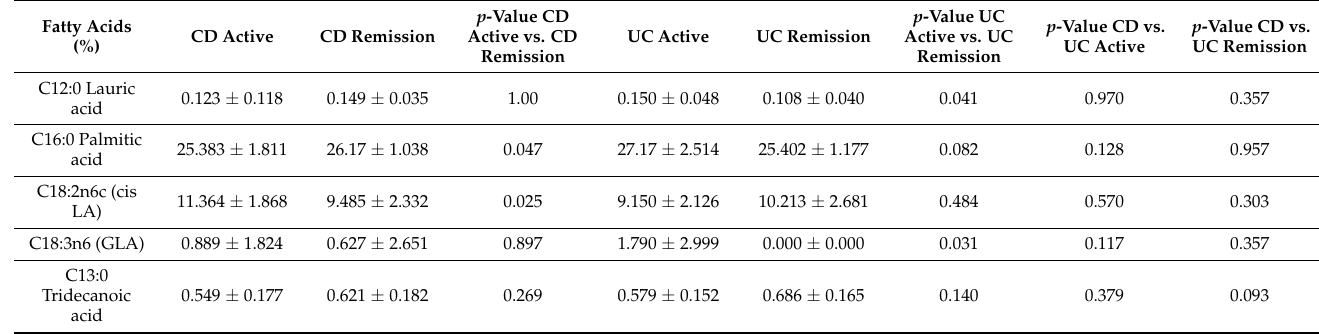
Table 3. Characteristics of fatty acids in CD and UC patients in active phase and remission